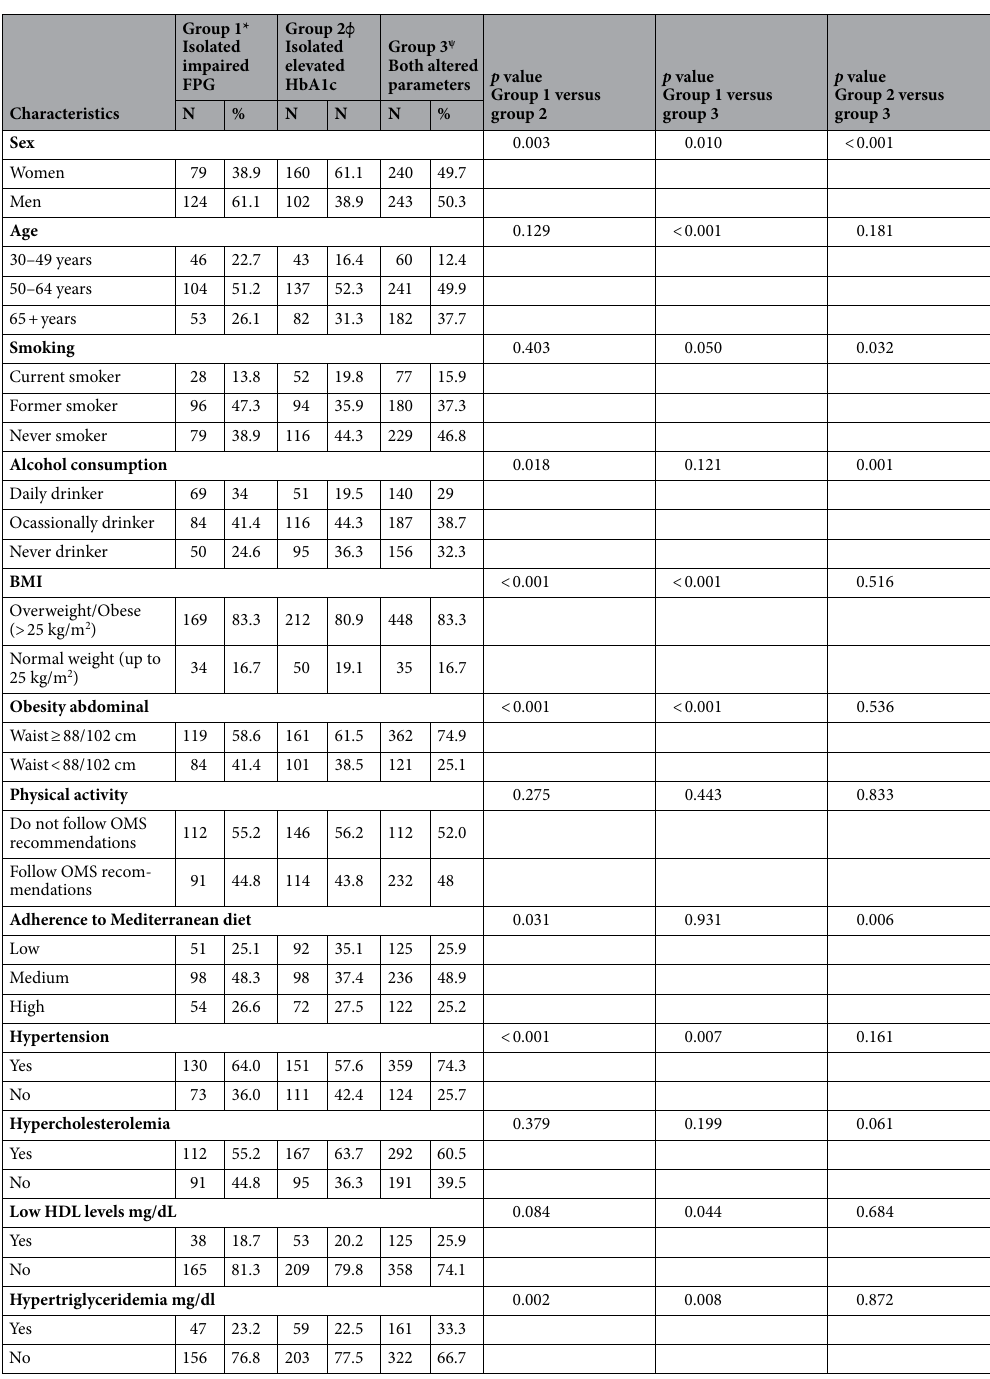
Table 1. Baseline characteristics of study cohort individuals according type of prediabetes. *Chi square of heterogeneity. *Group 1, Isolated impaired FPG. Defined as FPG: 100–125 mg/dl and HbA1c: < 39 mmol/ mol (<